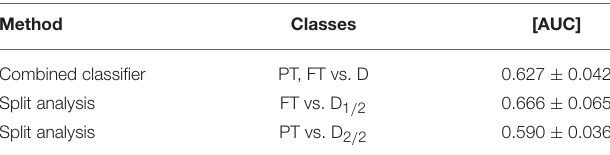
TABLE 2 | Results of the combined classifier and the split analysis in condition M (averages and standard deviations of the 16 participants of the study).